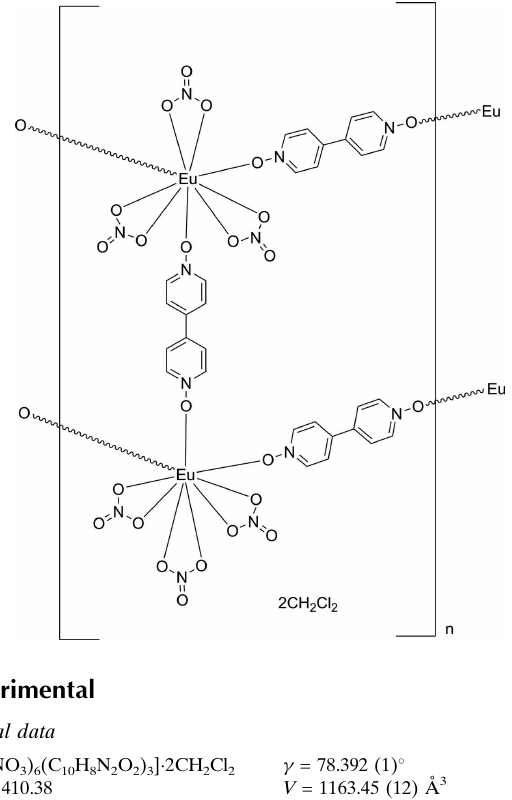
The title one-dimensional coordination network,